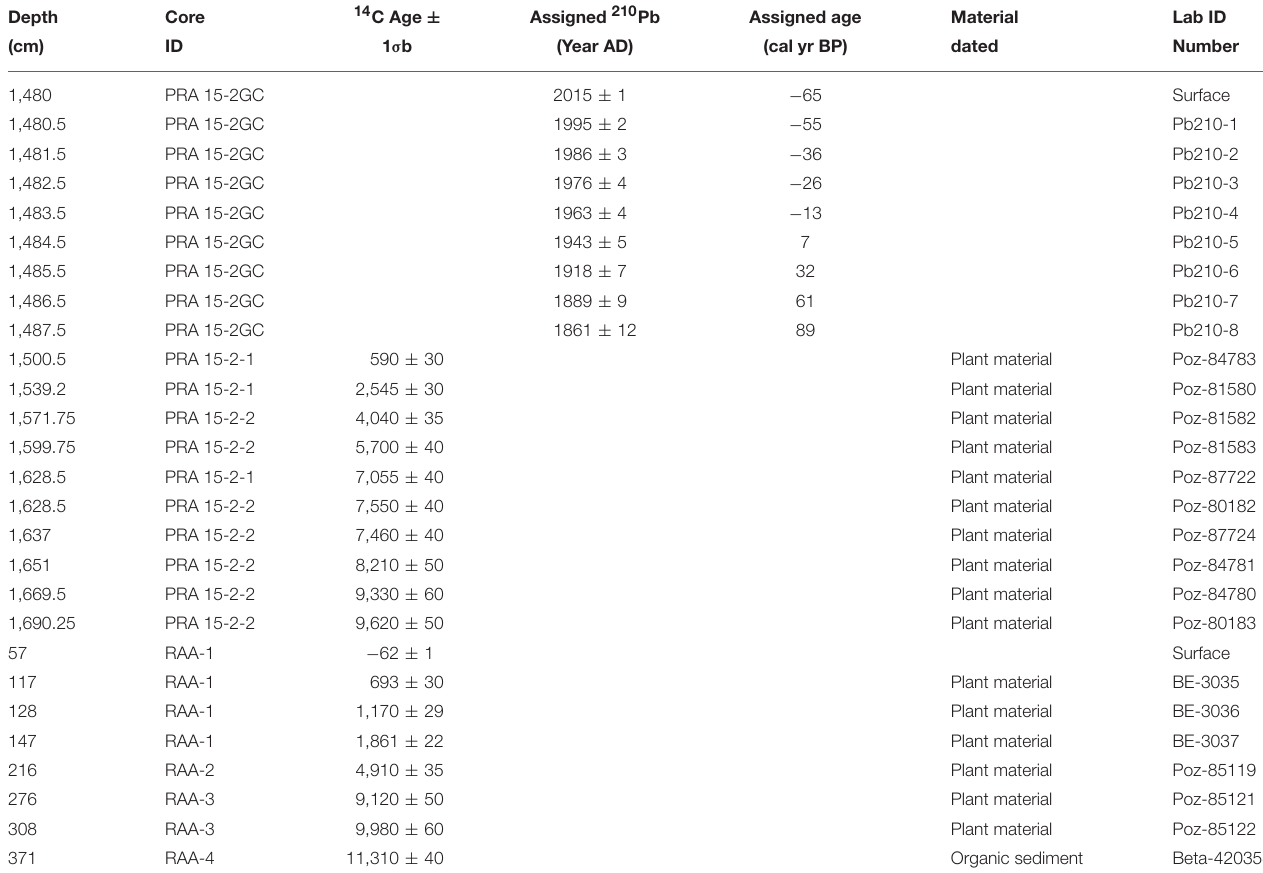
TABLE 1 | Summary of age-depth relationships for Prášilské jezero (Core IDS, PRA-15GC2, PRA 15-2-1, and PRA 15-2-2), Czech Republic and Rachelsee (Core ID, RAA1-4), Germany.